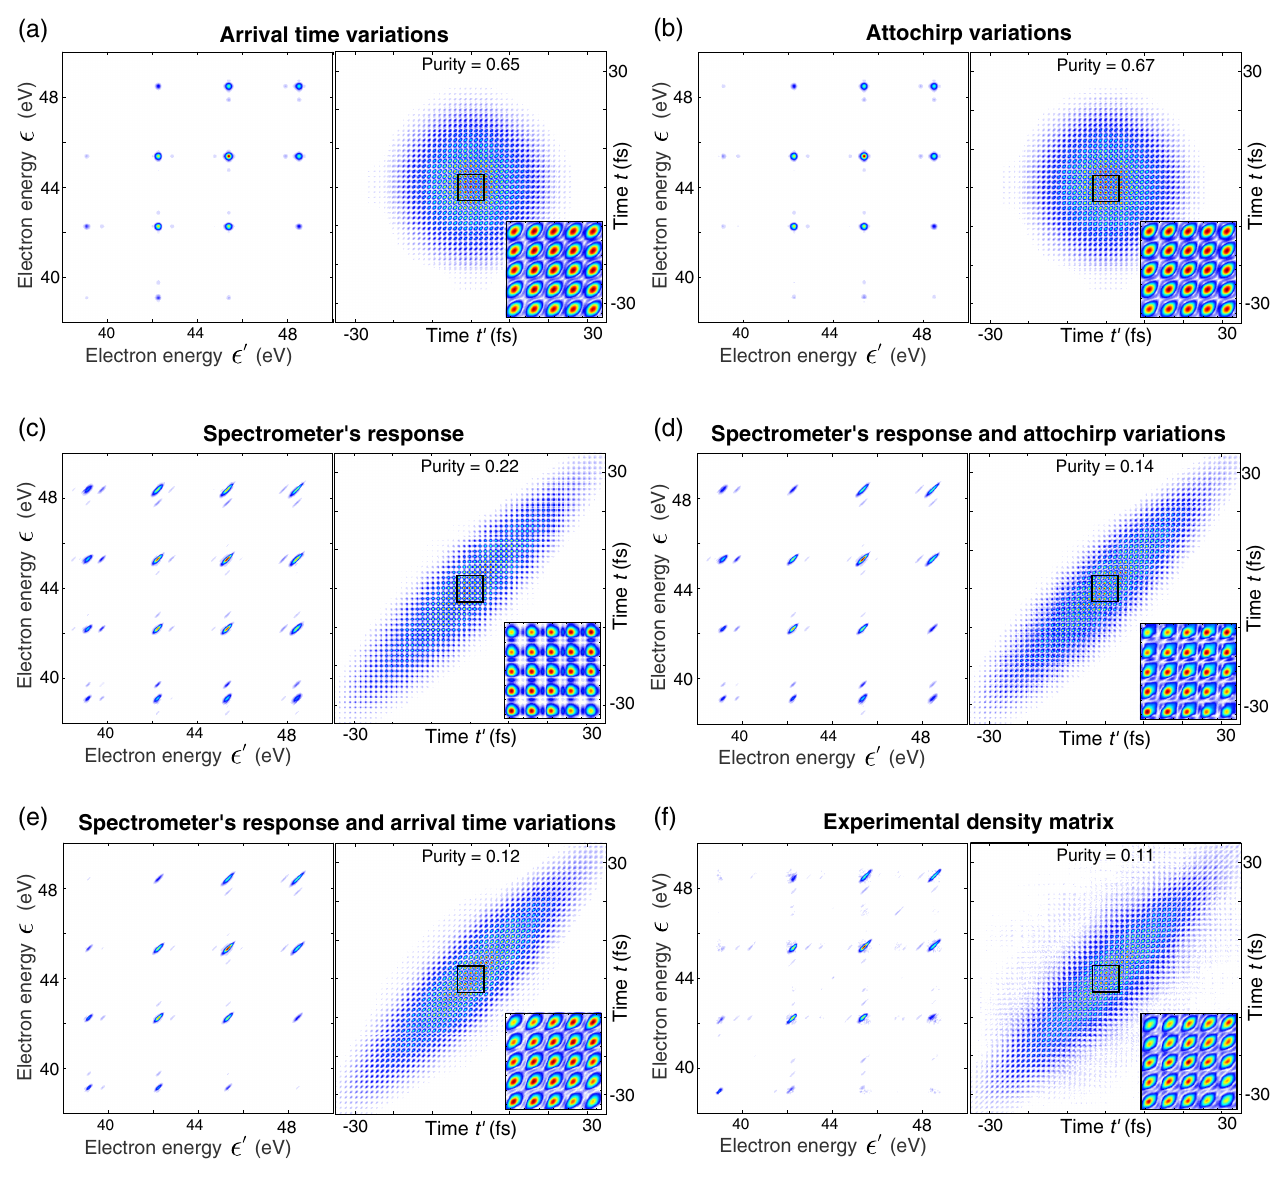
FIG. 8. For each decoherence model (a) – (e), the density matrix ρ In each case, the density matrix is depicted in the energy domain (left) and in the time domain (right); only the modulus is